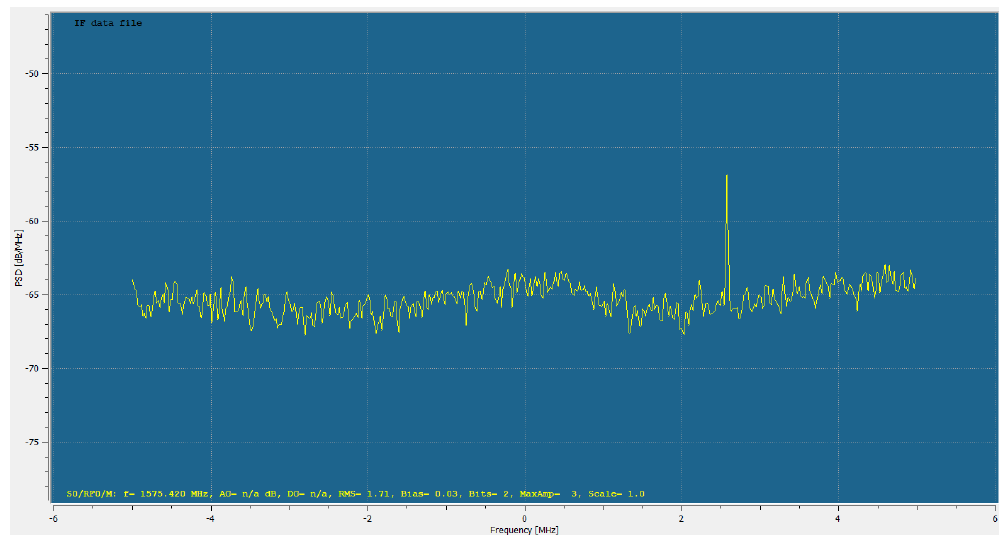
Figure 12. Frequency spectrum of the GPS L1 band with a root-mean-square (RMS) of the samples = 1.71. At frequency offset of approximately 2.5 MHz a continuous wave evaluating to β s µ , RMS (CW) interference peak is present. The dataset was recorded with a measurement van during a measurement campaign. Based on the CW interference being present during the complete measurement run, it is assumed that it was caused by one of the active on-board measurement instruments or radio connections. Additionally, it is assumed that the present CW interference does not influence the measurement because it is significantly outside the main lobe of the analysed GPS L1 C/A (Coarse/Acquisition)